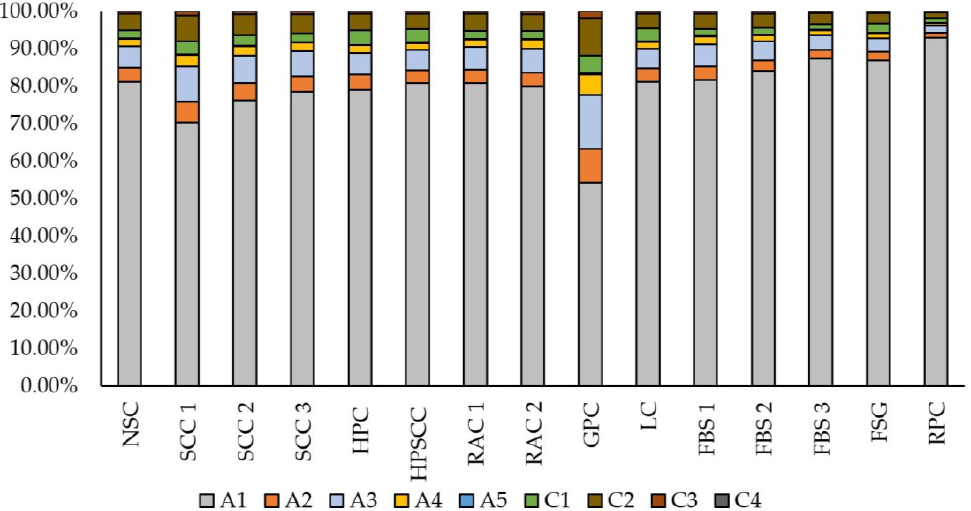
Figure 10. Percentage contribution of the different life cycle phases of the analyzed concretes to the carbon footprint value.